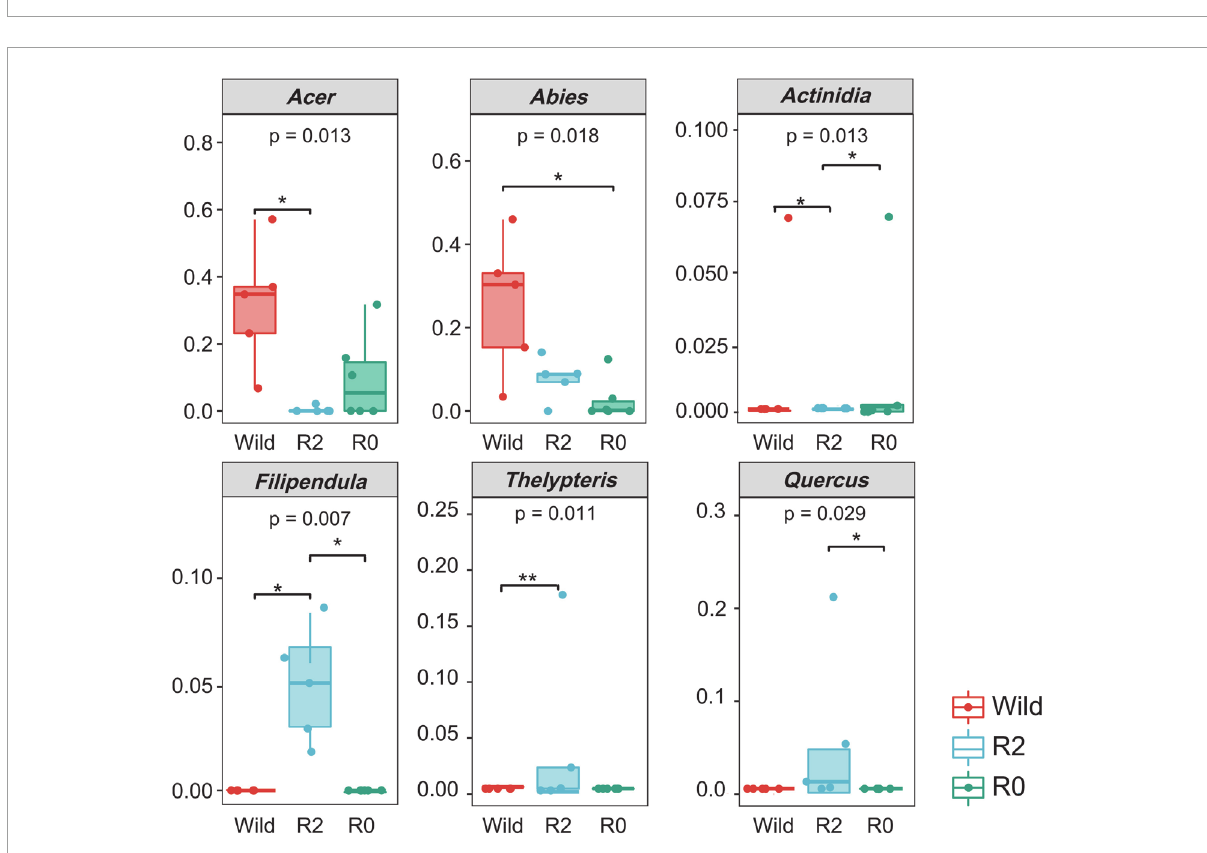
FIGURE3 Difference in the proportion of plants consumed between three groups ( p < 0.05) Colors represent different groups. * represents significant and ** represents very significant.